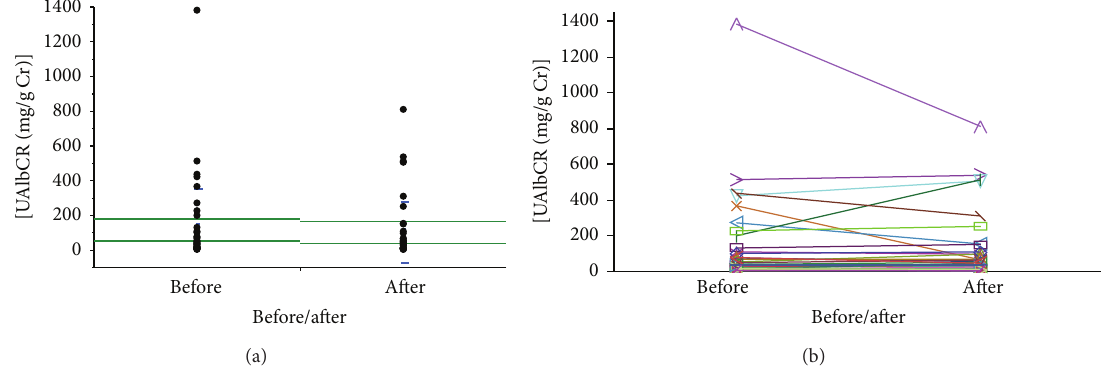
Figure 1: (a) Urinary concentrations of Alb normalized by urinary concentrations of creatinine (UAlbCR) before and 12-week after treatment with alogliptin. Alogliptin treatment tended to decrease UAlbCR ( 99.6 ± 26.8 versus 114.6 ± 36.0 mg/g Cr, 𝑃 = 0.1976 ). (b) UAlbCR of each participant before and 12-week after treatment with alogliptin.